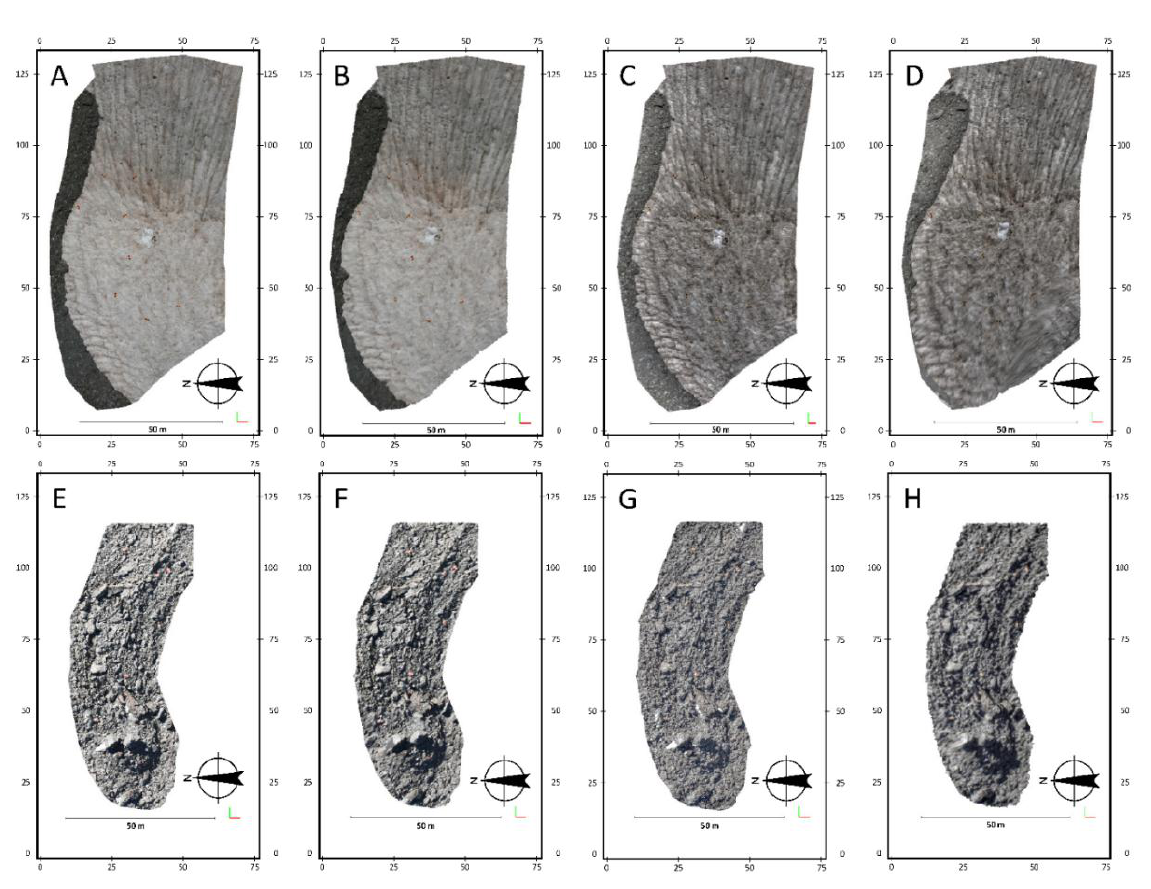
Figure 4. Resulting point clouds obtained with ( A ) Low Dynamic Range (LDR) images in Agisoft Photoscan for the year 2011, ( B ) LDR images in 123D Catch for the year 2011, ( C ) High Dynamic Range (HDR) images in Agisoft Photoscan for the year 2011, ( D ) HDR images in 123D Catch for the year 2011, ( E ) LDR images in Agisoft Photoscan for the year 2014, ( F ) LDR images in 123D Catch for the year 2014, ( G ) HDR images in Agisoft Photoscan for the year 2014 and ( H ) HDR images in 123D Catch for the year